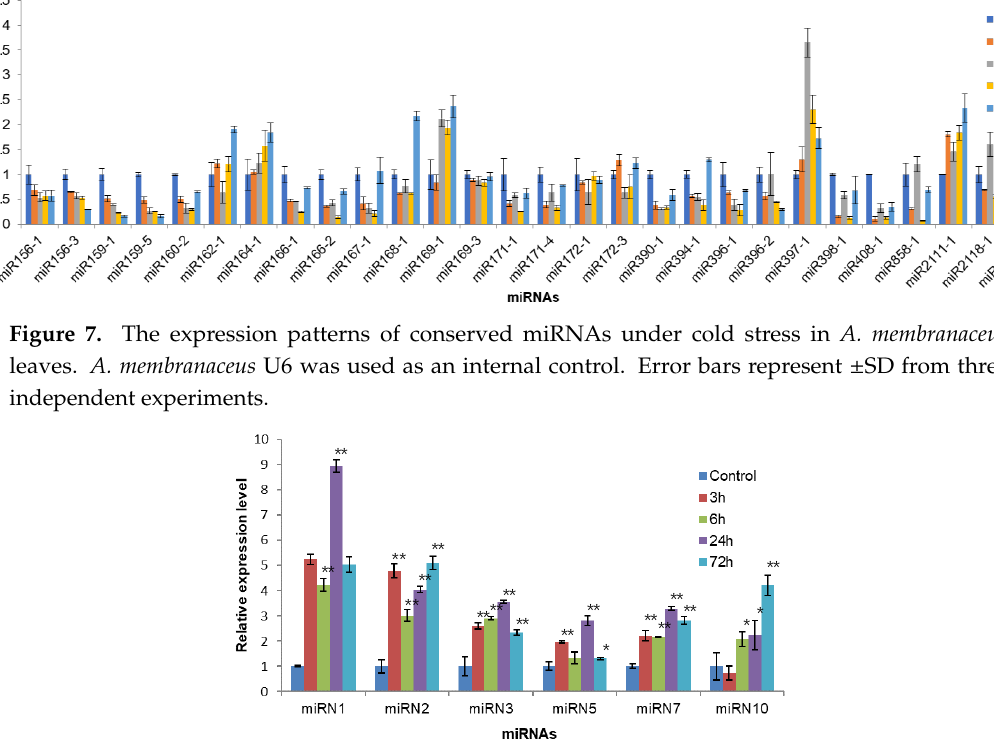
Figure 8. The expression patterns of six selected non-conserved miRNAs under cold stress in A. membranaceus leaves. A. membranaceus U6 was used as an internal control. Error bars represent ±SD from three independent experiments. * P < 0.05 compared to the control group, ** P < 0.01 compared to the control group.